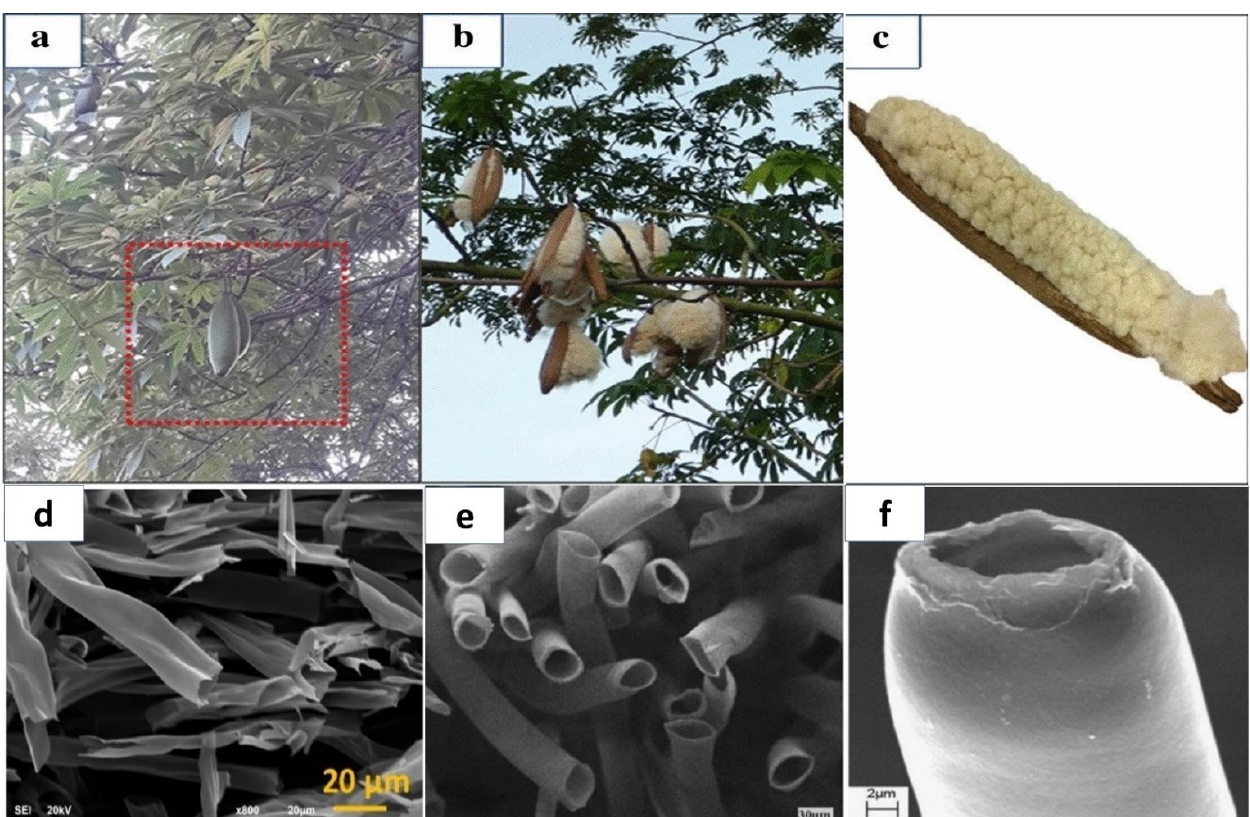
Figure 2. ( a ) Kapok Fiber tree, ( b ) A kapok fruit, ( c ) KF fruit. Reprinted with permission from Ref. [66]. Copyright 2017, copyright Elsevier; SEM scans represent the body ( d ). Reprinted with permis-